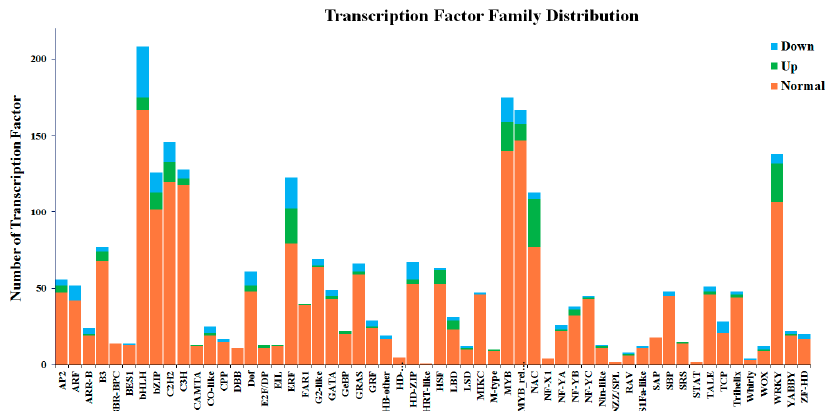
Figure 8. The differentially expressed transcription factors (TFs) of buckwheat in response to salt stress. The up and down regulated TFs were represented by the green or blue color, respectively.